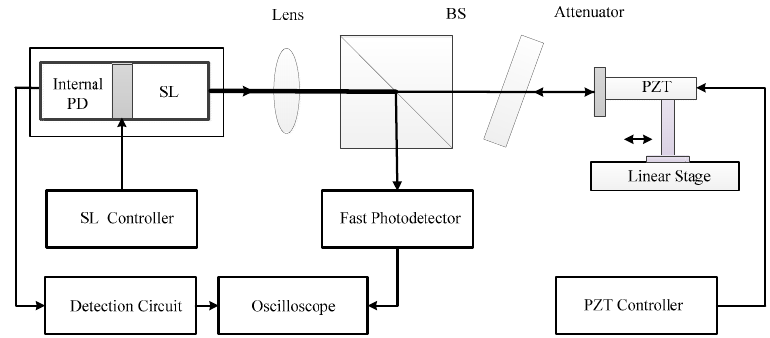
Figure 5. Experimental set-up. BS: beam splitter; PD: photodiode; SL: semiconductor lasers; PZT: piezoelectric transducer.